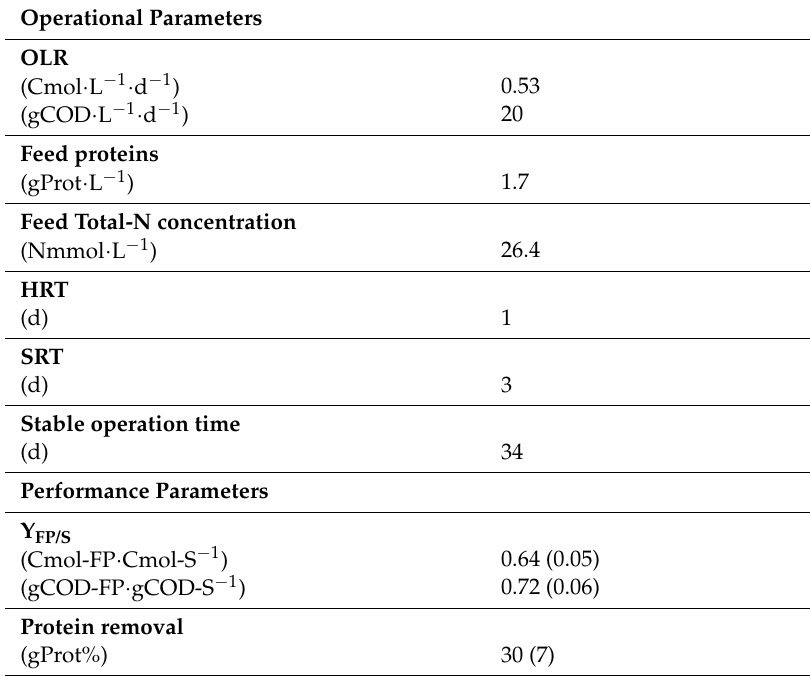
Table 1. Summary of the operational conditions tested and the performance of the AnMBR, and fermented cheese whey